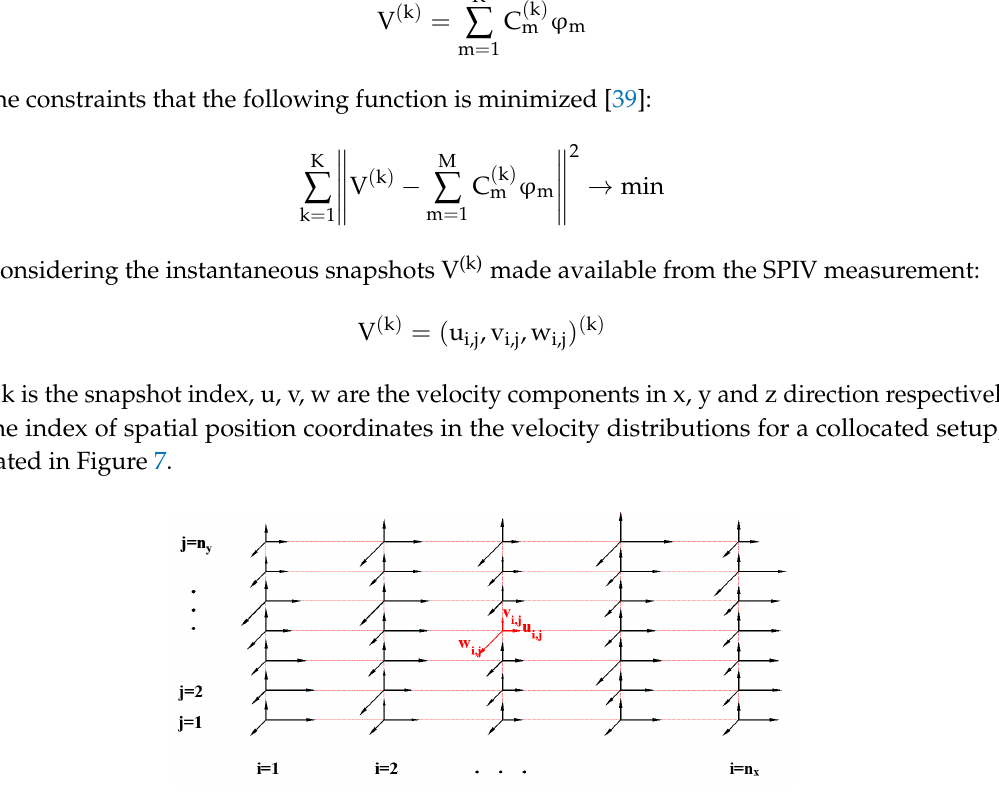
Figure 7. Example of discrete SPIV data on a uniform collocated grid.